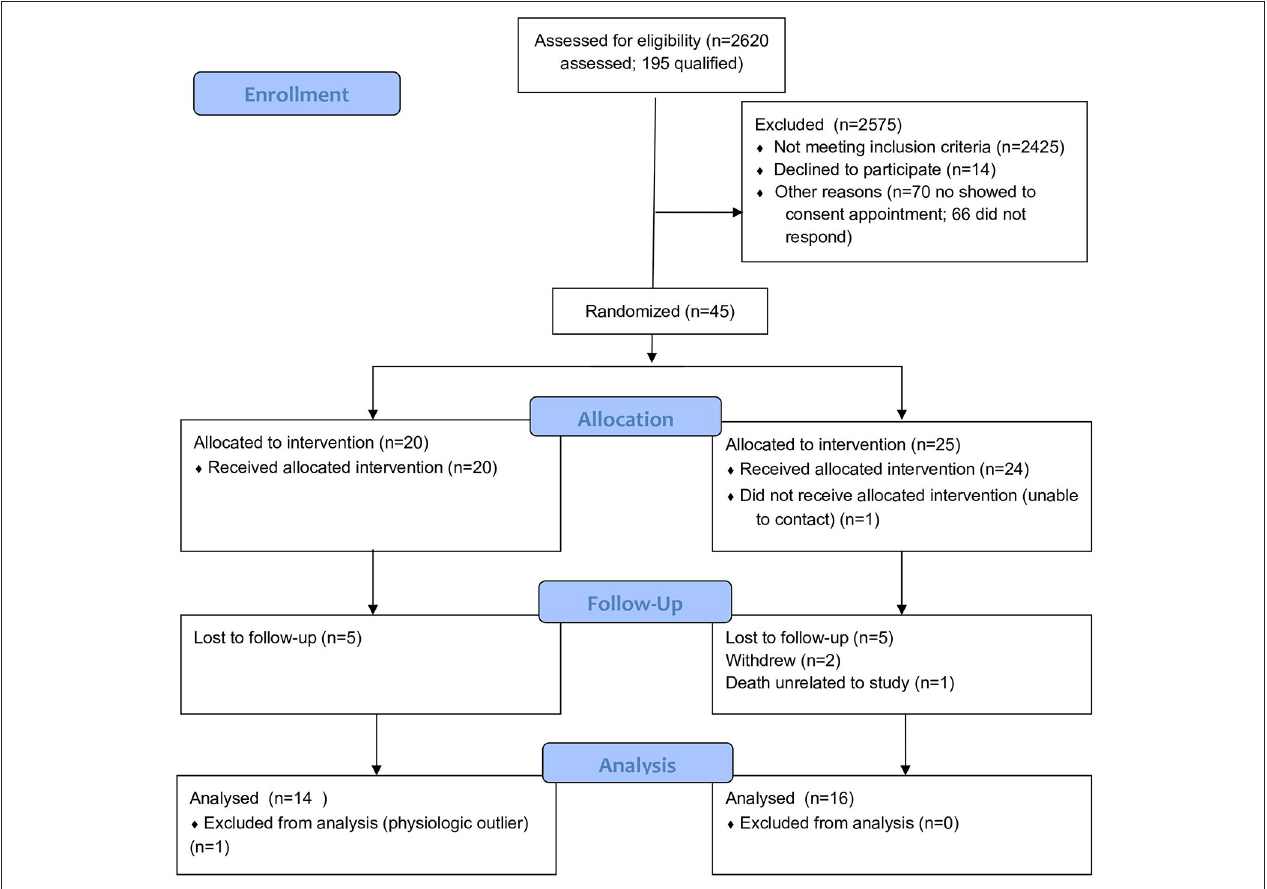
FIGURE 2 | CONSORT flow diagram of the Healthy at Home randomized controlled trial of digital health coaching for type 2